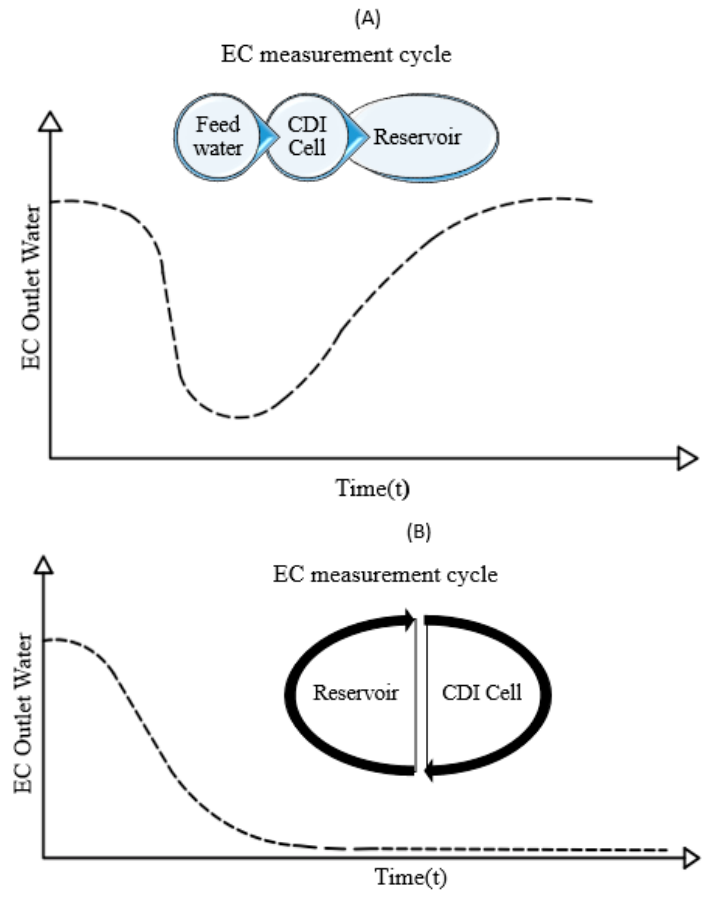
Figure 9. Schematic of two designs used in CDI experiments: ( A ) Single-Pass (SP) method, ( B ) Batch- Mode (BM) method. Mode (BM)